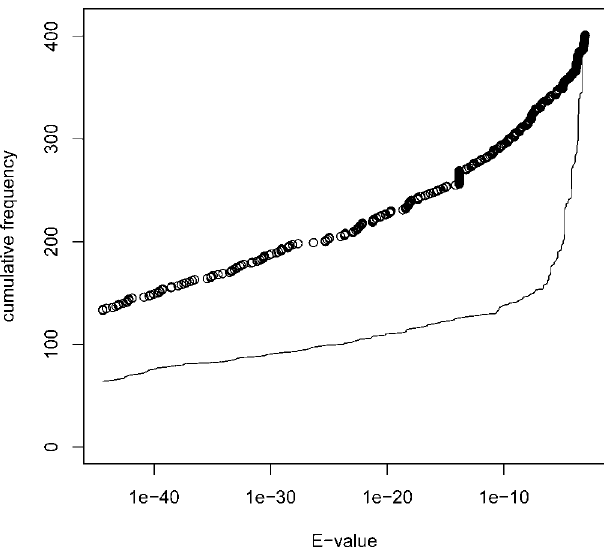
Figure 6. Similarity between Mouse Expressed Pseudogenes and Human Genomic Sequences BLAST E -values are shown for murine expressed pseudogenes (line) and paired Swiss-Prot sequences (circles) versus human genome contigs. The total number of reported alignments is similar for both datasets; however, Swiss-Prot entries have consistently twice as many alignments with low E -values (0 , E , 10 (cid:2) 10 ), and with E ¼ 0, than do expressed pseudogenes. Alignments with E ¼ 0 (132 and 63, respectively) are not visualised as points on the plot, but their respective quantities can be deduced from the shifts of both curves at the root. DOI: 10.1371/journal.pgen.0020023.g006